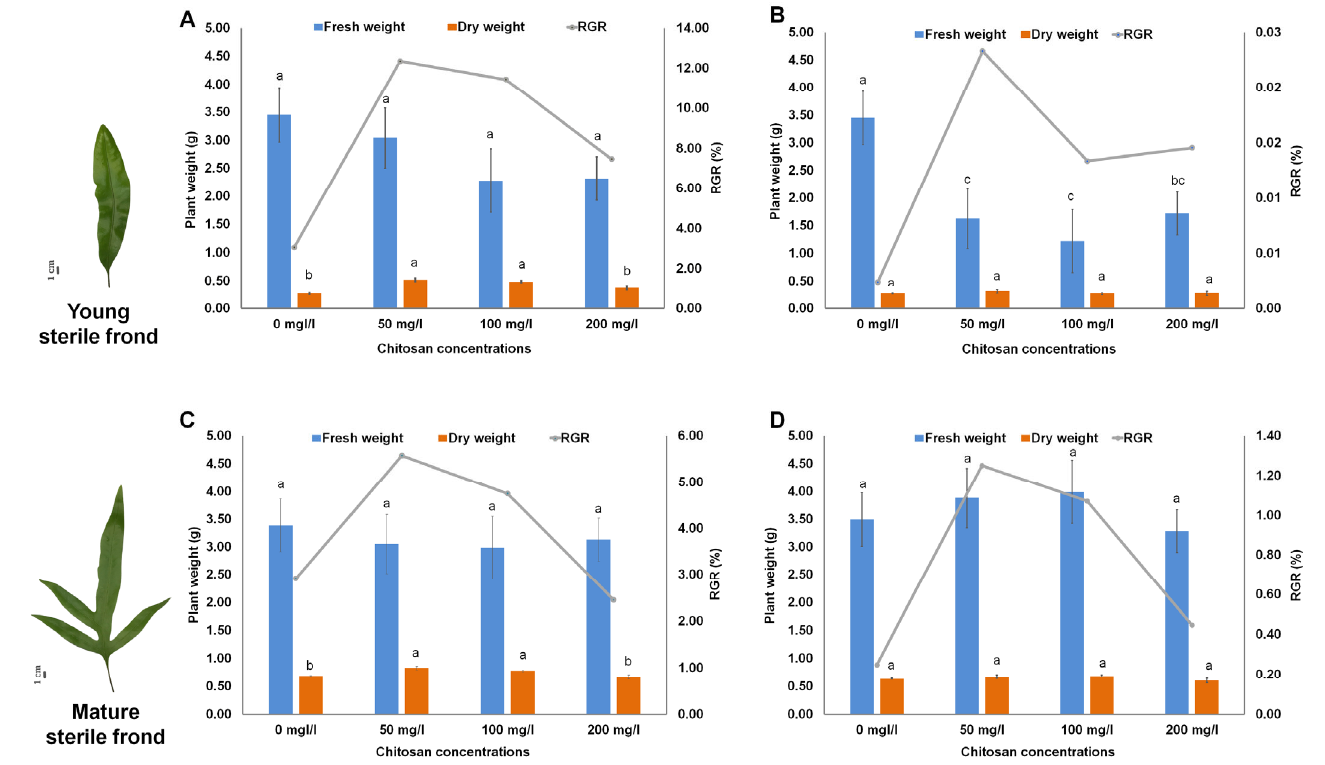
Figure 1. Influences of foliar chitosan application on growth of Microsorum scolopendria by measuring fresh weight and dry weight of young sterile fronds at 7 days after treatment (DAT) ( A ) and 14 DAT ( B ) and mature sterile fronds at 7 DAT ( C ) and 14 DAT ( D ). Data are presented as means ± standard error of the mean (SE) (n=3). Different letters on top of bars indicate a significant difference ( p ≤ 0.05) according to Duncan’s multiple range test.